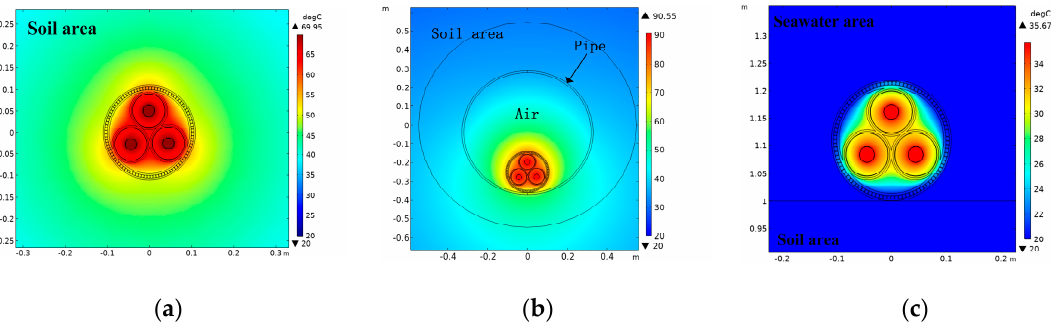
Figure 4. The temperature field distribution of submarine cable for three laying methods. ( a ) The temperature field distribution of submarine cable for direct burial laying. ( b ) The temperature field distribution of submarine cable for pipe laying. ( c ) The temperature distribution of submarine cable for sub-sea